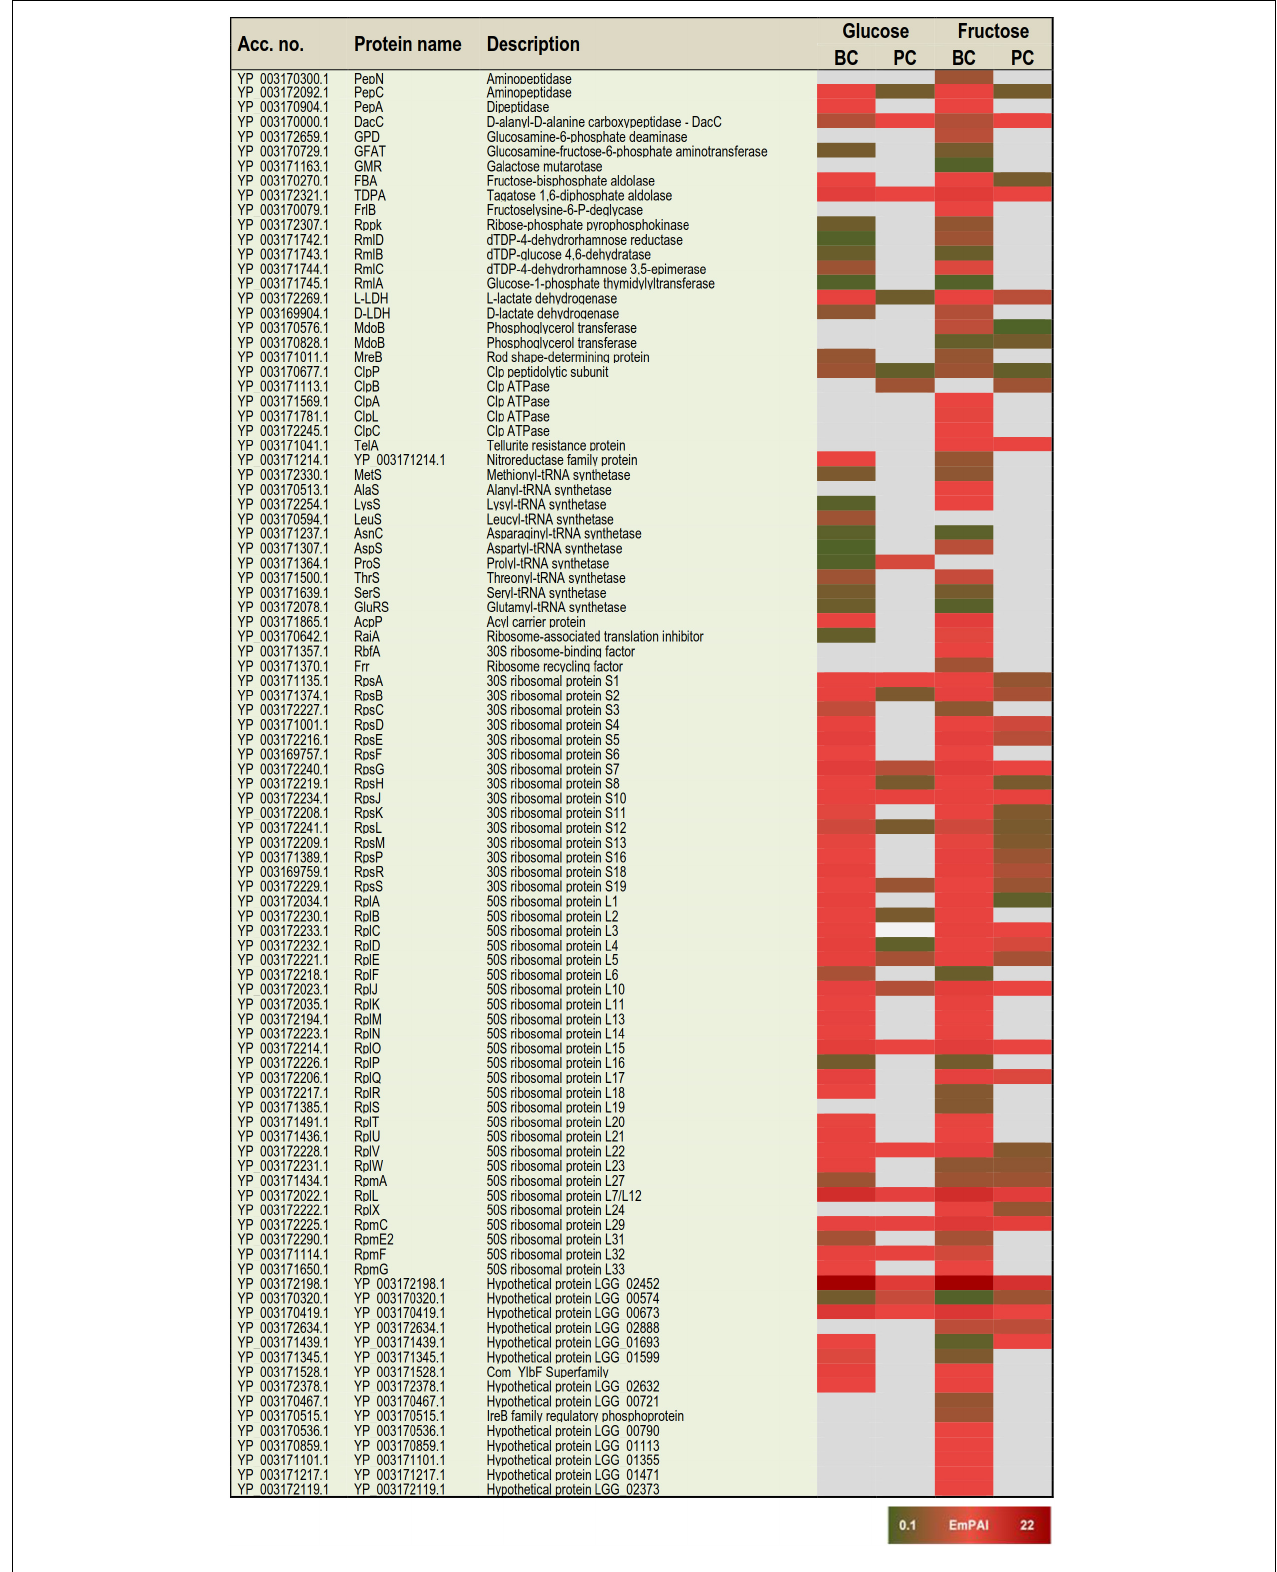
FIGURE 4 | A heat map comparing the most distinctive protein abundance changes (estimated by the emPAI values) among the predicted moonlighters. Red and green refer to higher and lower protein abundances, respectively.